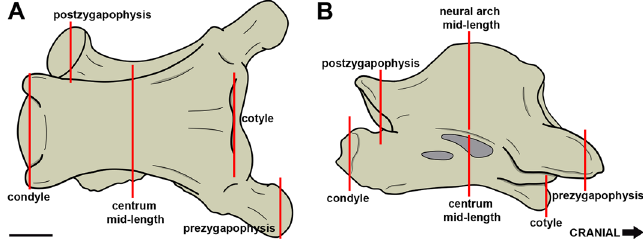
Figure 7. Transverse sections used for ASP calculation. Light grey: pneumatic foramina. Scale bar: 10